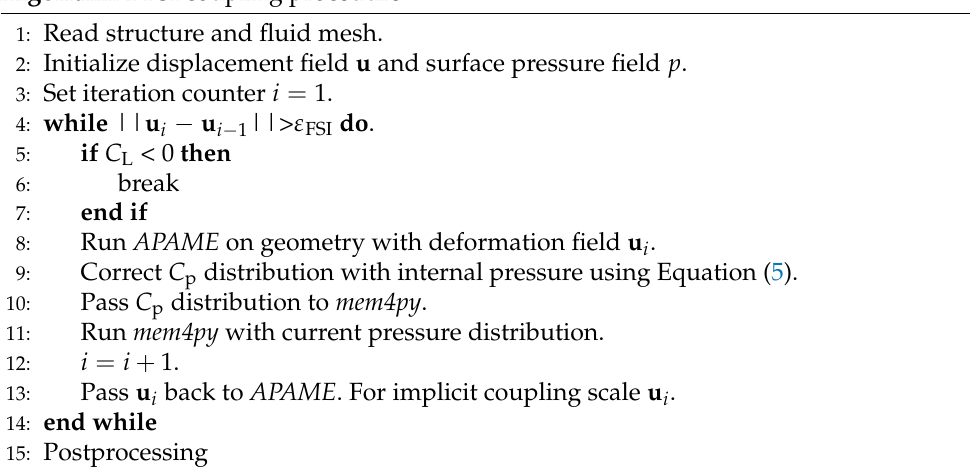
Algorithm 1 FSI coupling